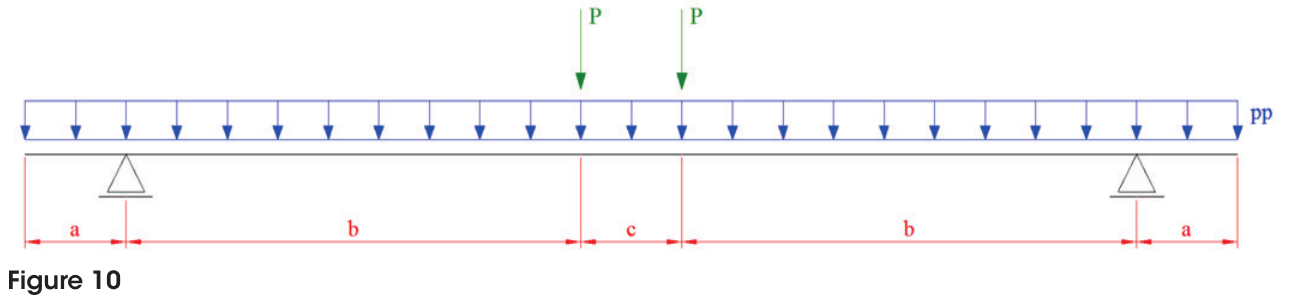
Results for the negative bending tests (Part 2)